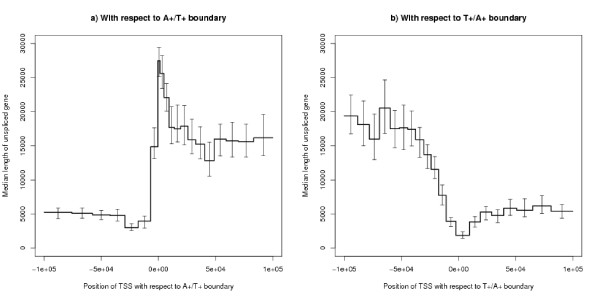
Median length of gene by position of TSS with respect to the segment boundaries. The bins have been defined by the quantiles of the distribution within the range plotted. The error bars show 95% confidence ranges using Hettmansperger-Sheather's method. (a) shows the A+/T+ boundary and (b) shows the T+/A+ boundary. a) in each bin, n ~ 788; b) in each bin, n ~ 655.